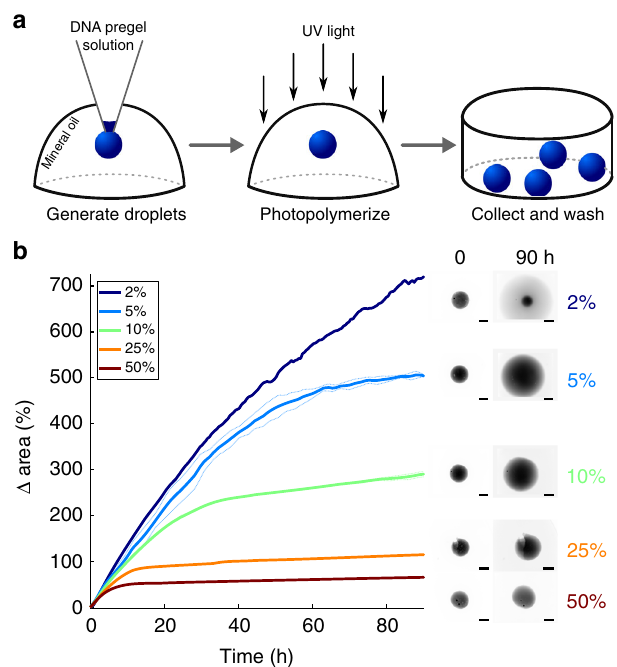
Fig. 2 Hydrogel particle synthesis and tunable swelling with DNA hairpin fuel and terminators. a Hydrogel particles are prepared by pipetting droplets of pre-polymer acrylamide-DNA crosslinker solution into mineral oil and polymerizing the droplets with UV light. Rhodamine-B is incorporated into the acrylamide backbone to allow fl uorescence imaging of particles (see Methods). b The changes in area of the 2D projection of particles without locks over time for different fractions of hairpin monomers that are terminating hairpins. Each solid curve represents 1 particle (2%, 25%, 50%) or the average of measurements of 2 particles (5%, 10%); dotted lines are the individual replicates of each average. The edges of particles expanded with 2% terminator monomer were unable to be discerned from the surrounding solution after 90 h. Hairpin fuel with 10% terminator was chosen for further hydrogel swelling experiments because particles with 2% and 5% terminator expanded to a diameter larger than the microscope ’ s fi eld of view. Image intensities are scaled based on each image ’ s minimum and maximum intensity. Scale bars: 500 µ